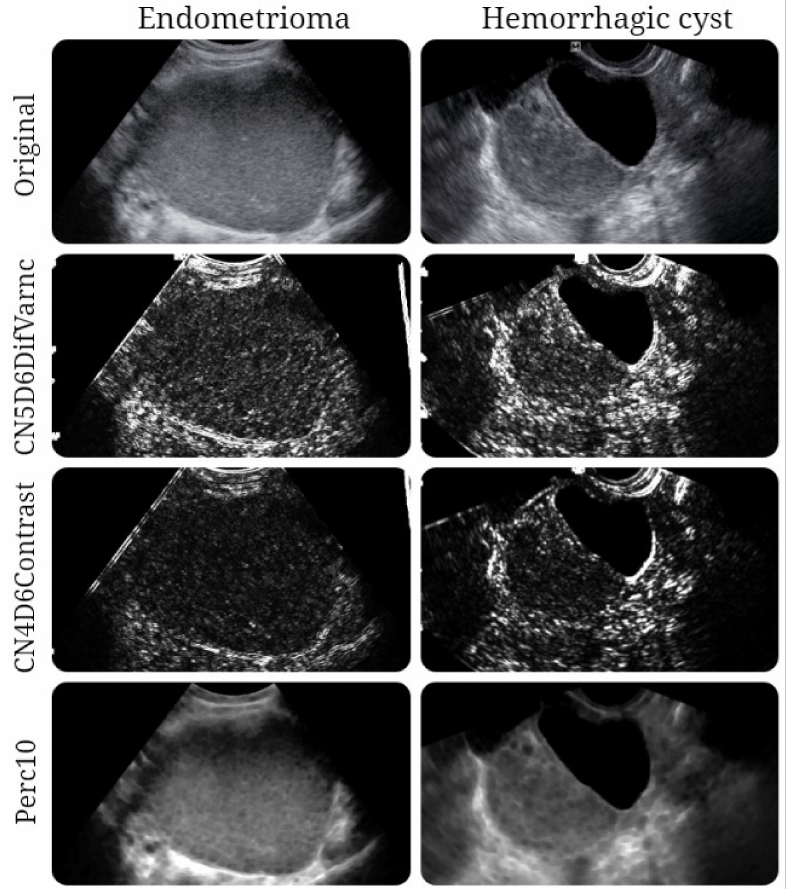
Figure 4. Texture maps showing the distribution of three texture parameters (CN5D6DifVarnc, CN4D6Contrast, and Perc10) in images of patients with a histologically proven endometrioma and hemorrhagic ovarian